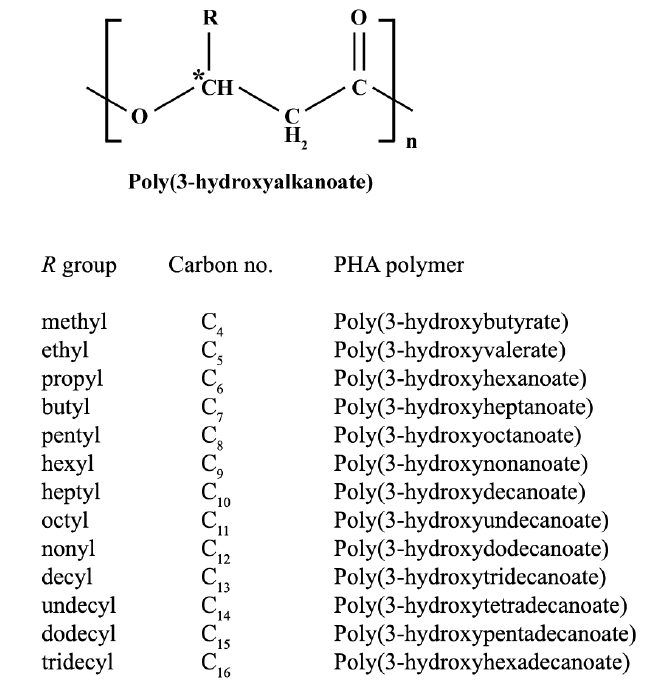
Figure 1. Polyhydroxyalkanoate (PHA) chemical structure. The nonmenclature and carbon number for PHA compounds is determined by the functional alkyl R group. Asterisk denotes chiral center of PHA-building block.